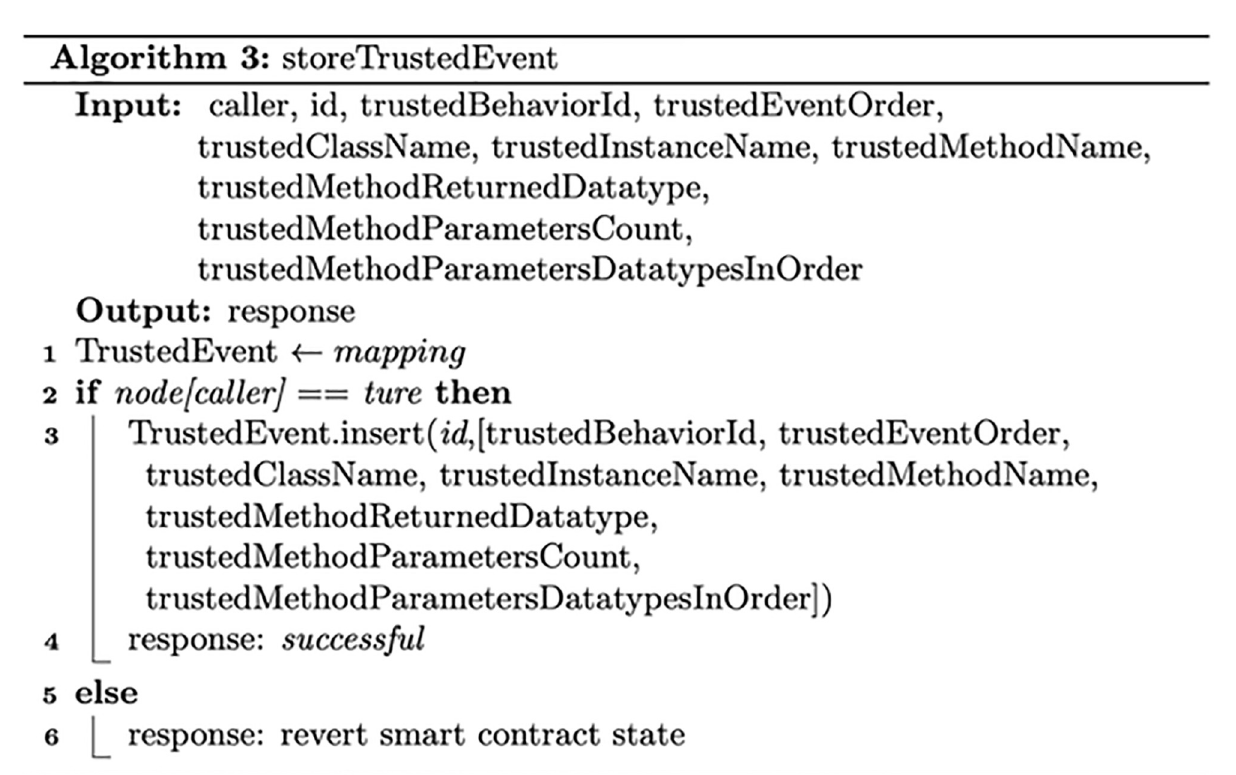
Fig 4. The process of storing and managing trusted software